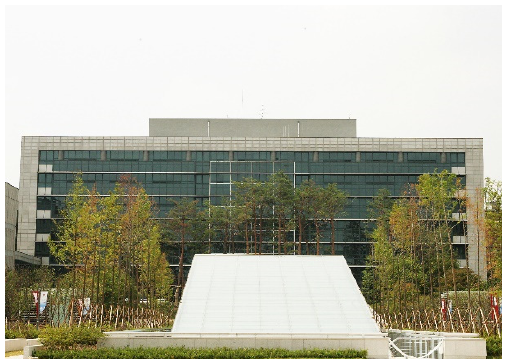
Figure 8. Campus building A (R&D